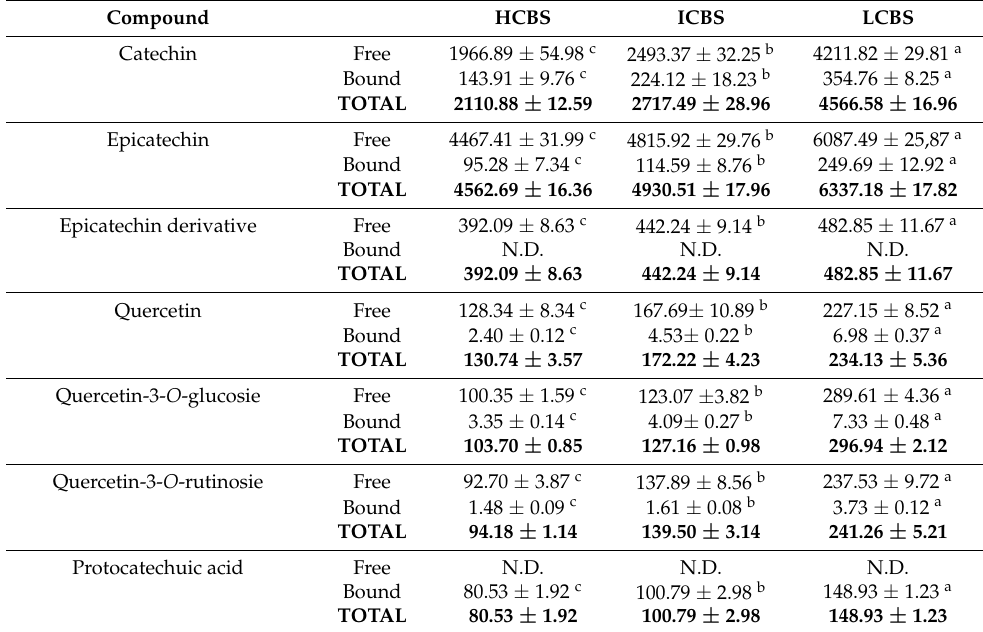
Table 5. Effect of particle size on the polyphenolic profile of cocoa bean shell